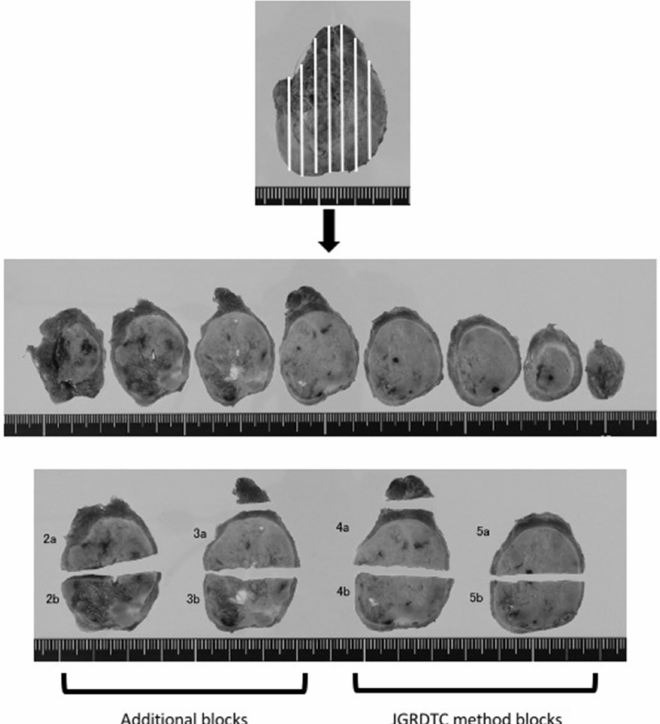
Figure 1. Examination of thyroid nodules based on recommendations of the Japanese Society of Thyroid Surgery. Multiple sagittal cuts at 3 mm intervals of a thyroid nodule, 37 mm diameter, after formalin fixation are shown (middle). In this study, four “JGRDTC method blocks” were prepared, comprising slices resected from the maximum cut surface (4a and 4b) and resected slices selected by gross examination (5a and 5b). In addition, 4 additional blocks were prepared (2a, 2b, 3a, and 3b) using 2 resected sections selected by gross examination